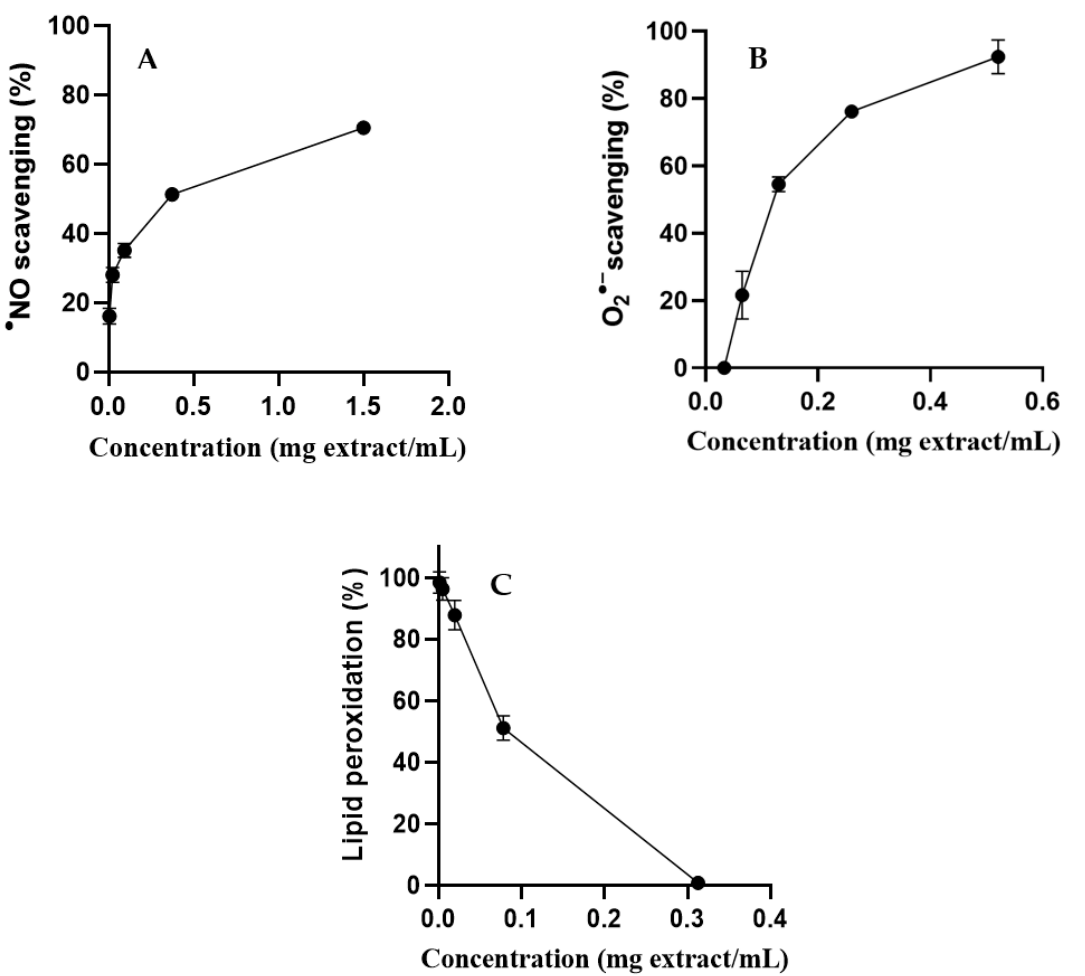
Figure 4. • NO scavenging ( A ), O 2• − scavenging ( B ) and inhibition of lipid peroxidation ( C ) by S. betaceum leaf aqueous extract. Results are expressed as mean ± SD of three independent experiments, each performed in